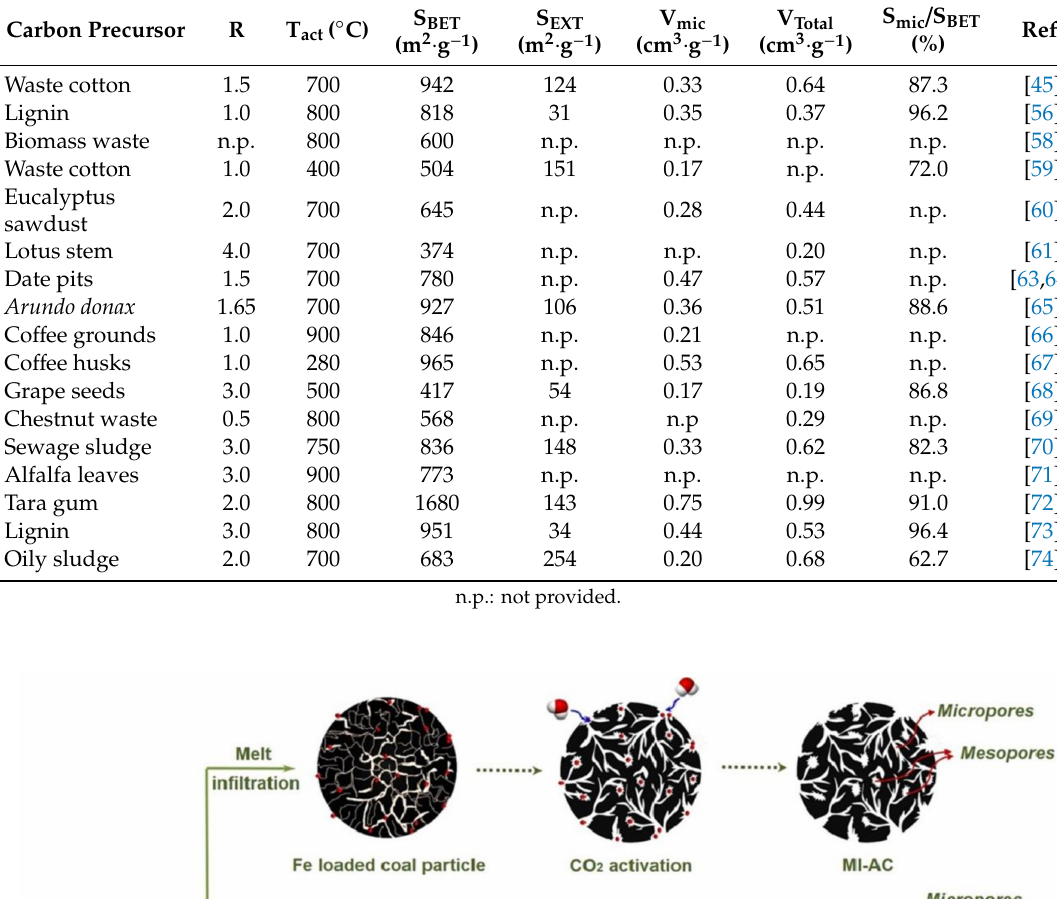
Table 2. Characteristic parameters of the porous texture and conditions used to maximize the surface area of activated carbons obtained from di ff erent carbon precursors, using FeCl 3 as activating agent.